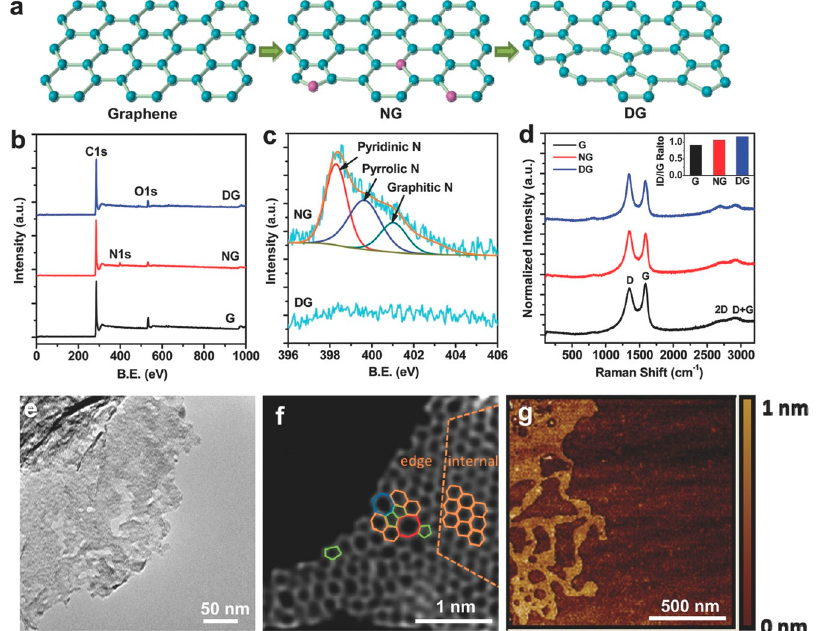
Figure 3. ( a ) Schematic illustration of the synthesis process of defect-rich graphene (DG). ( b ) X-ray photoelectron spectroscopy (XPS) spectra of the pristine graphene, NG, and DG. ( c ) The corresponding high-resolution N1s XPS spectra of NG as well as DG. ( d ) Raman spectra of pristine graphene, NG, and DG. ( e ) TEM image of DG sample. ( f ) HAADF image of DG sample determined at an accelerated voltage of 80 kV. Hexagons (orange), pentagons (green), heptagons (blue), and octagons (red) ( g ) The representative atomic force microscopy (AFM) image of DG sample. (Figures are reprinted with permission from Ref. [24], 2016 WILEY-VCH).